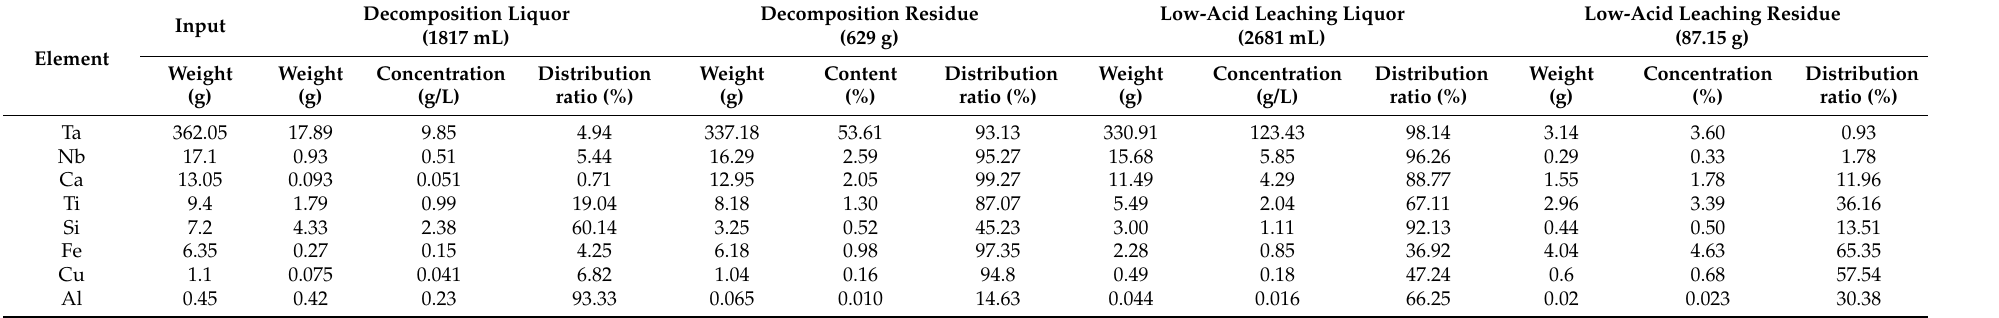
Table 3. Results of the comprehensive experiment of low-acid leaching of decomposition